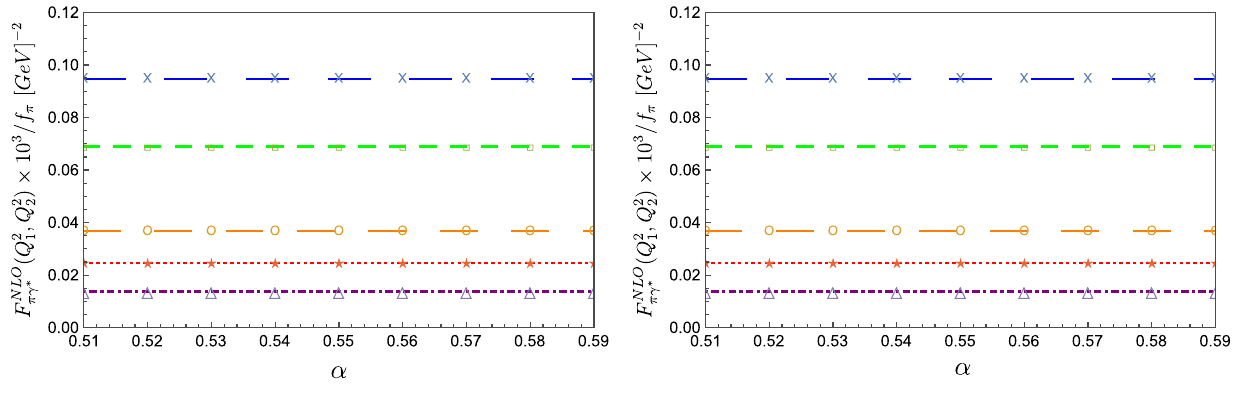
GeV 2 . Small dashed green line and green square points for ( Q 2 = 4 . 27 ) GeV 2 . Dotted red line and red star points for 14 . 83 ; Q 2 2 ( Q 2 = 38 . 11 ; Q 2 = 14 . 95 ) GeV 2 . Dot-Dashed purple line and purple 1 2 = Q 2 = 6 . 48 ) GeV 2 . Middle = Q 2 = 45 . 63 ) GeV 2 . Left panel for GSWL1. triangle points for ( Q 2 1 2 1 2 = Q 2 = 16 . 85 ) Right panel for GSWL2 1 2